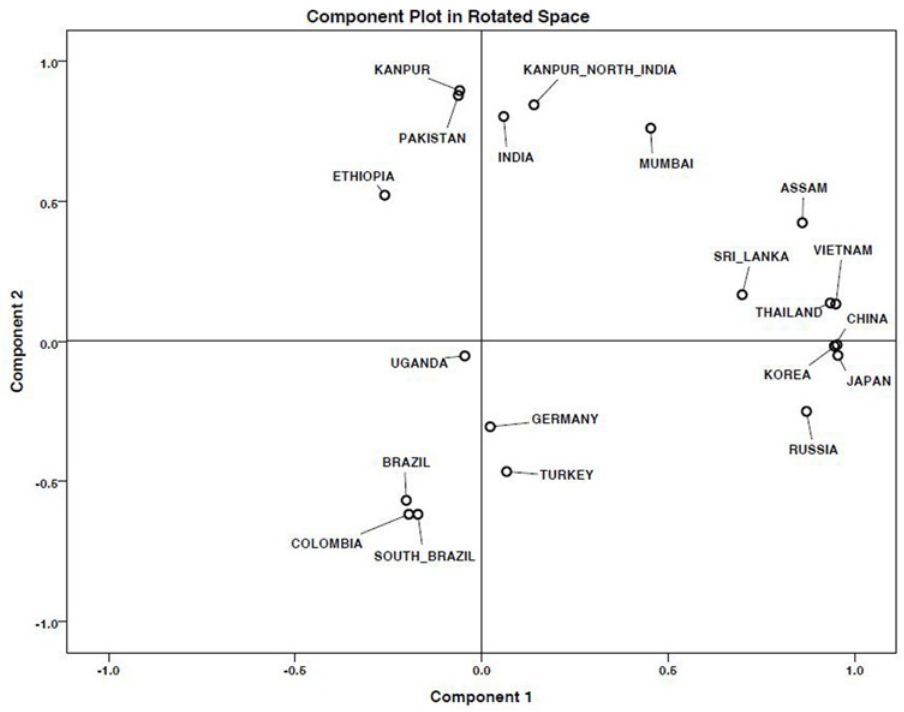
Fig 2. A two dimensional scatter plot based on principal component analysis (PCA). Geographical regions having similarity in patterns of spoligotypes tend to clusters